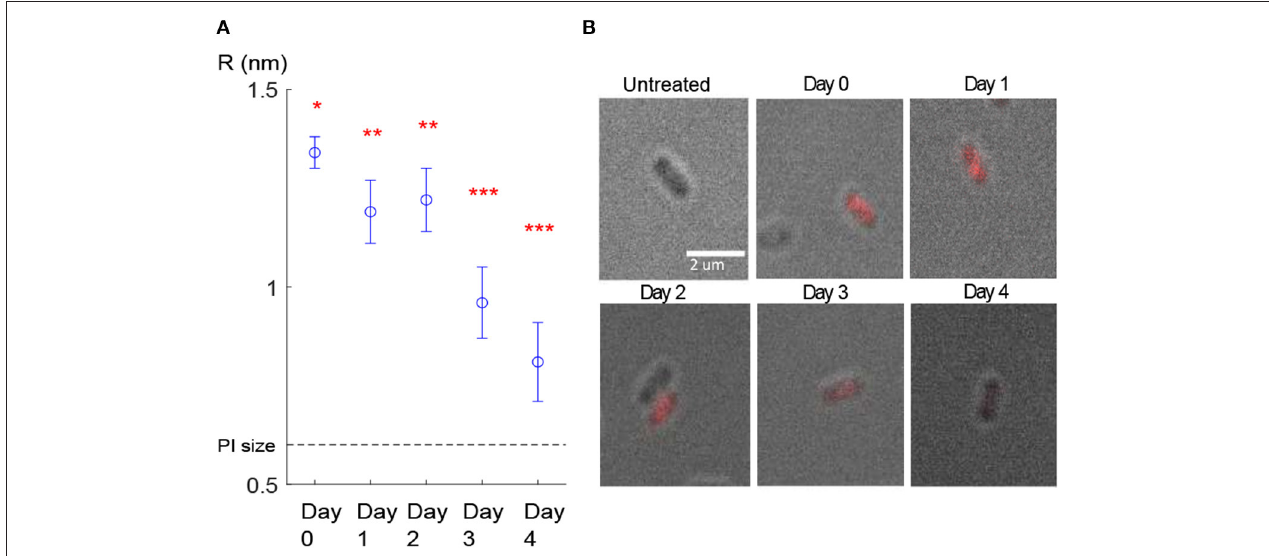
FIGURE 4 | Pore size estimation. (A) Estimated pore radius of the cells belonging to the cluster with the lowest slope. The mean value of pore radius for day 0 was significantly ( p < 10 − 6 ) different than the rest of the days. The mean value of the pore radius for days 1–2 was significantly different than days 3–4 (stars represent statistically different groups). Error bars show the confidence intervals, calculated using the Bonferroni method for multi-comparison (see 2.3). (B) The last frame (t = 30 min monitoring) of the fluorescence microscopy image stacks obtained in each evaluation day. Here only one cell as a representative for each day is shown.